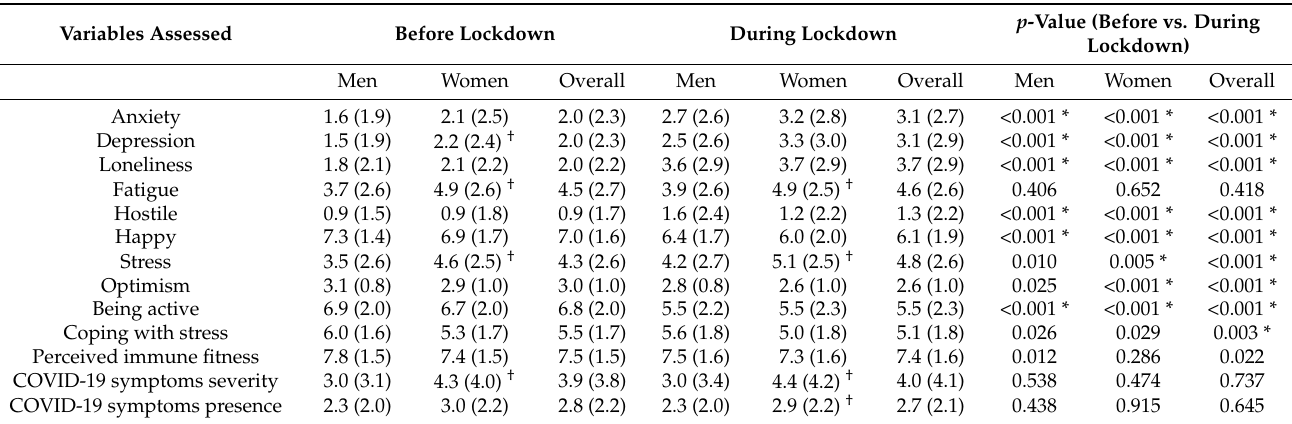
The study outcomes for 18- to 35-year-old participants, summarized in Table 4, show that during lockdown mood was significantly poorer compared to before lockdown. This was accompanied by significantly higher stress levels and poorer perceived immune fitness, but not by a significant increase in reported COVID-19 symptoms. Table 4. Means and standard deviations for assessments before and during